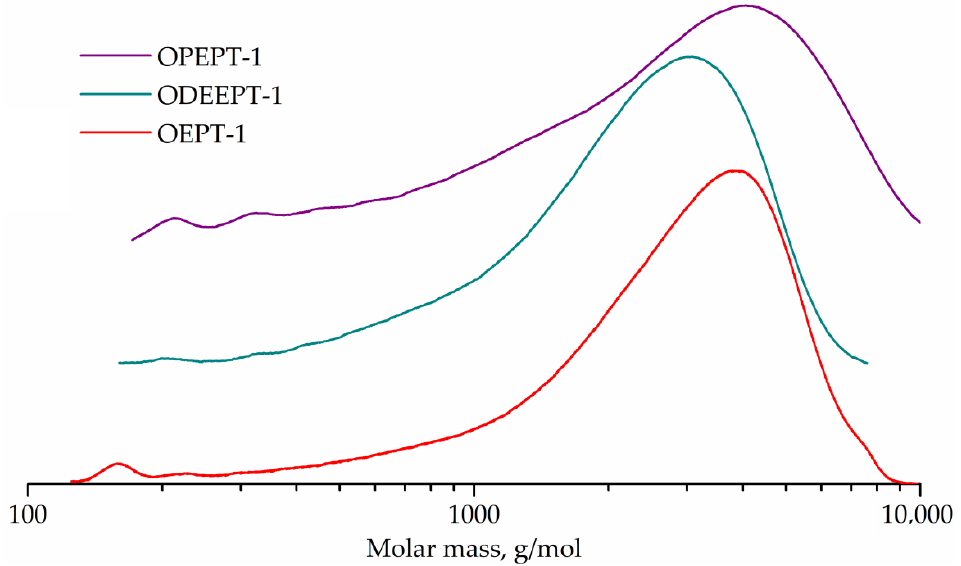
Figure 8. GPC curves of OEPT-1, ODEEPT-1, and OPEPT-1 samples.